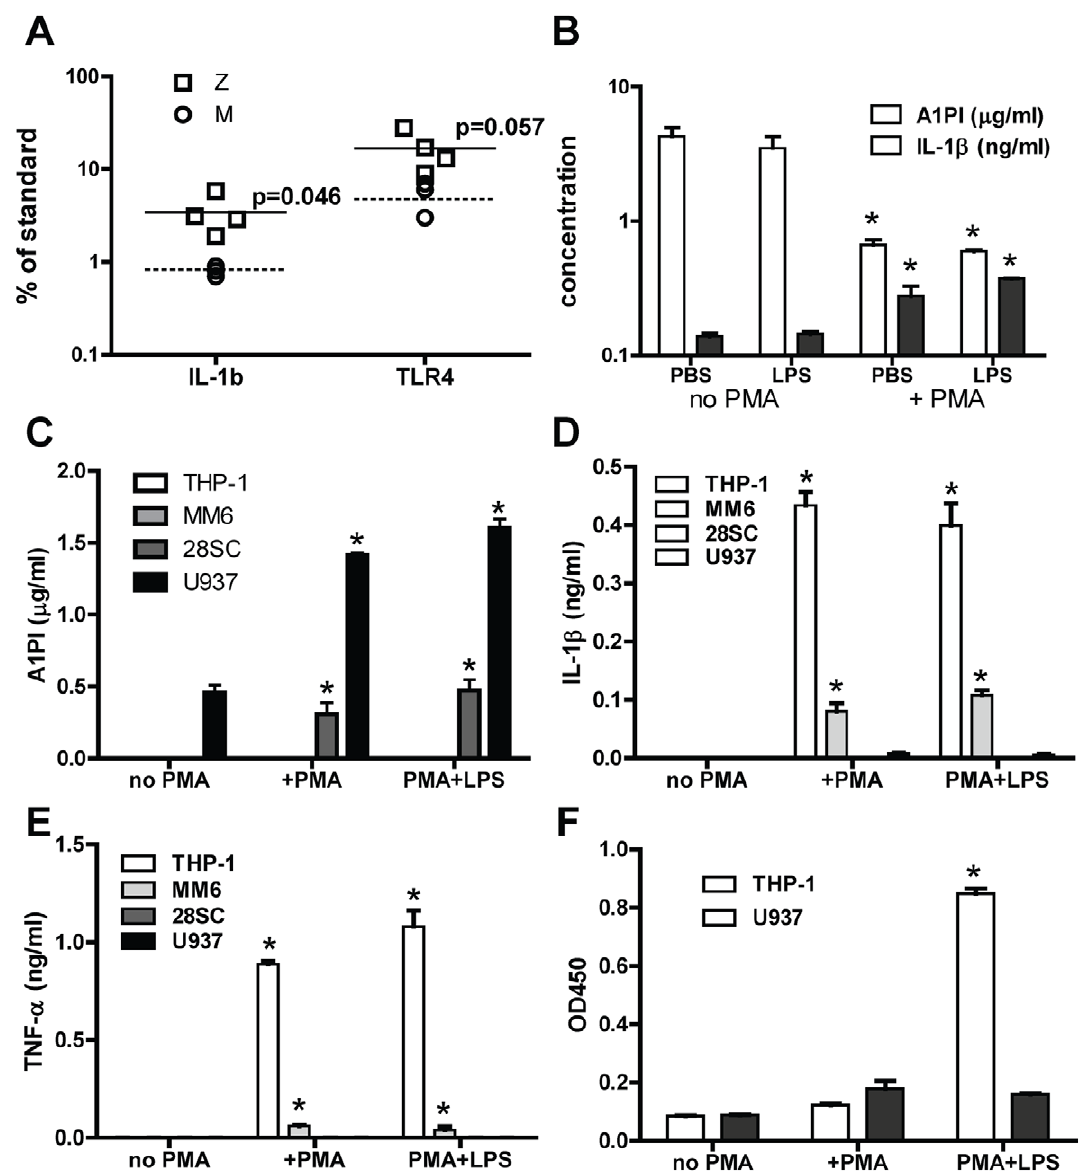
Figure 2. A1PI and Cytokine Secretion in Cultured Monocytes. A) IL-1 b and TLR4 transcripts were evaluated by quantitative PCR in alveolar macrophages acquired by bronchoalveolar lavage from PIZZ (squares) or PIMM (circles) outpatient volunteers (n=3–4). Bars indicate the mean values for PIZZ (filled bar) and PIMM (dashed bar) samples. B) Elutriated peripheral blood monocytes of healthy volunteers (n=3) were cultured 5 days with or without PMA and LPS stimuli as indicated. Secreted A1PI and IL-1 b were detected in collected supernatants by ELISA. C-E) Monocytic cell lines were cultured 5 days with or without PMA and LPS stimuli as indicated. Secreted A1PI (C), IL-1 b (D), and TNF- a (E) were detected in collected supernatants by ELISA. E) THP-1 and U937 cultured 4 days with PBS control or with PMA were washed, and LPS (100 ng/ml) was added to selected wells. Released nucleosome:DNA complexes were assessed in supernatants collected at 24 hours. Asterisks denote P # 0.05 compared with unstimulated control cells. For (A) through (E), representative results of 3 experiments are